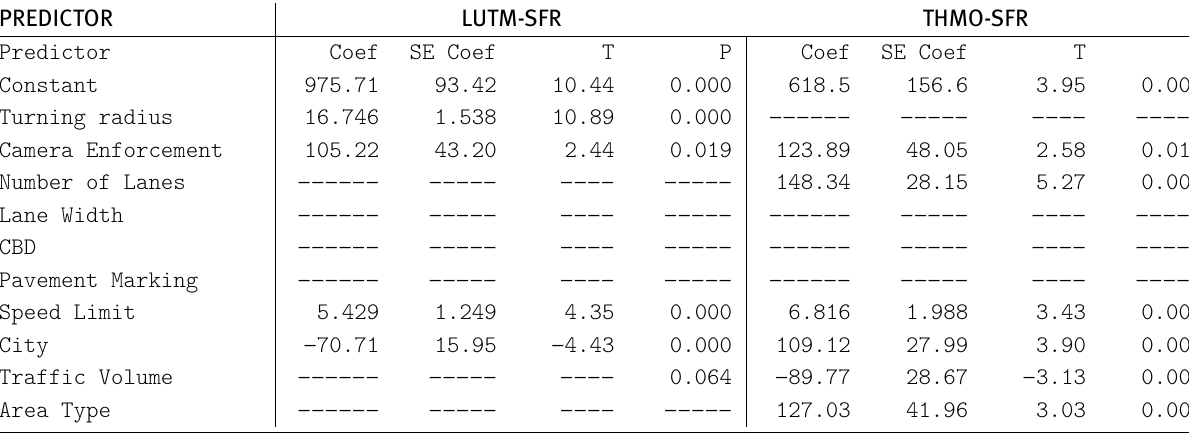
Table 4: Minitab Output Regression Analysis for the Significant Predictors